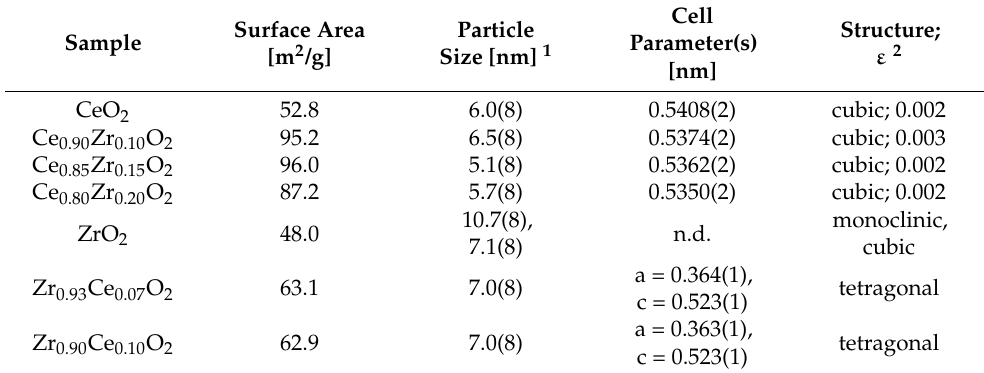
Figure 1. Characterization of selected supports and catalysts: ( a ) diffraction patterns and ( b ) XPS survey spectra. Table 1. Properties of selected